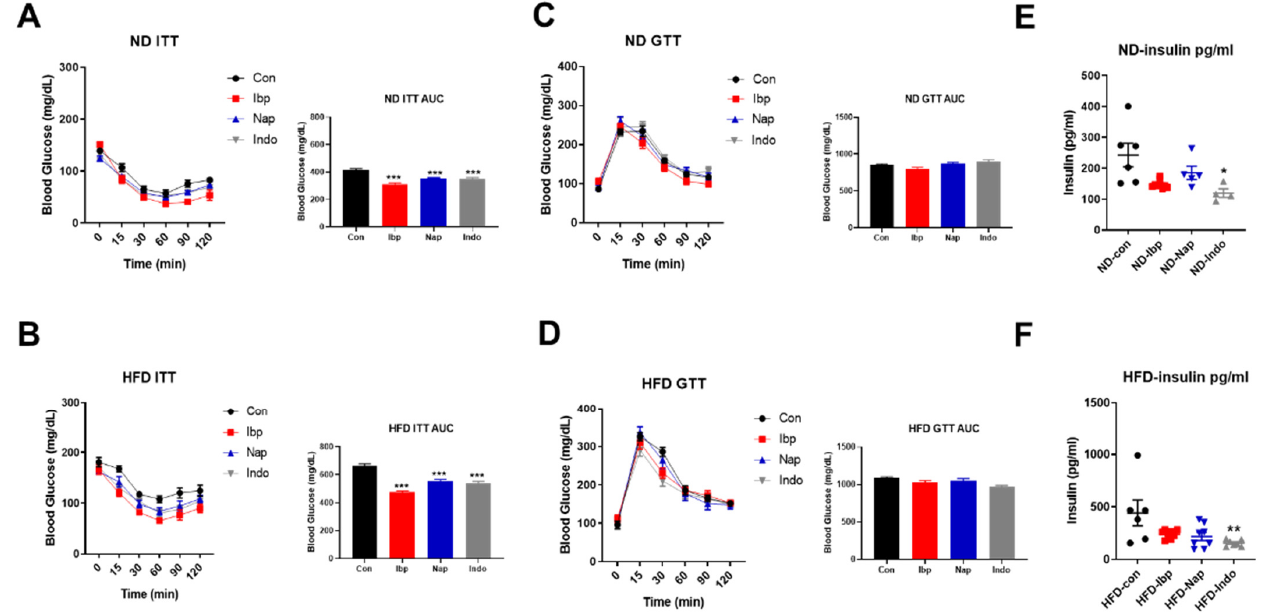
Figure 4. Chronic NSAIDs treatment in mice induces improvement in insulin but not glucose tolerance. Insulin tolerance test (ITT), glucose tolerance test (GTT), and fasting plasma insulin levels in C57 Blc/6J male mice placed on either ( A , C , E ) normal chow diet (ND) or ( B , D , F ) high-fat diet (HFD) and treated with PBS (Con), ibuprofen (Ibp), naproxen, (Nap), or indomethacin (Indo) afterr 3–4 weeks. n = 6 (Con), 11–12 (Ibp), 6–10 (Nap), and 5–8 (Indo). All results are presented as mean ± SEM (error bars). One WAY-ANOVA was used to compare the differences between control and the three NSAID groups for GTT and ITT. Student’s t test was used to compared means between controls and each NSAID group. Statistical significances are denoted with asterisks as follows: *, p ≤ 0.05; **, p ≤ 0.01; ***, p ≤ 0.001.